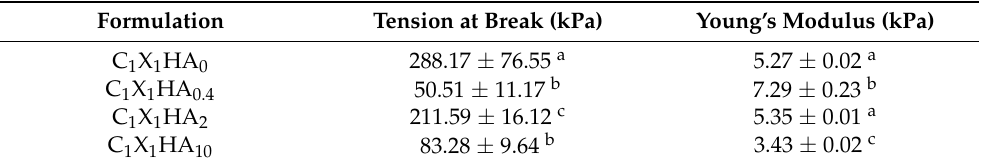
Table 2. Tensile strength and Young modulus of chitosan-xanthan membranes prepared with different concentrations of hydroxyapatite after exposure to PBS for 1